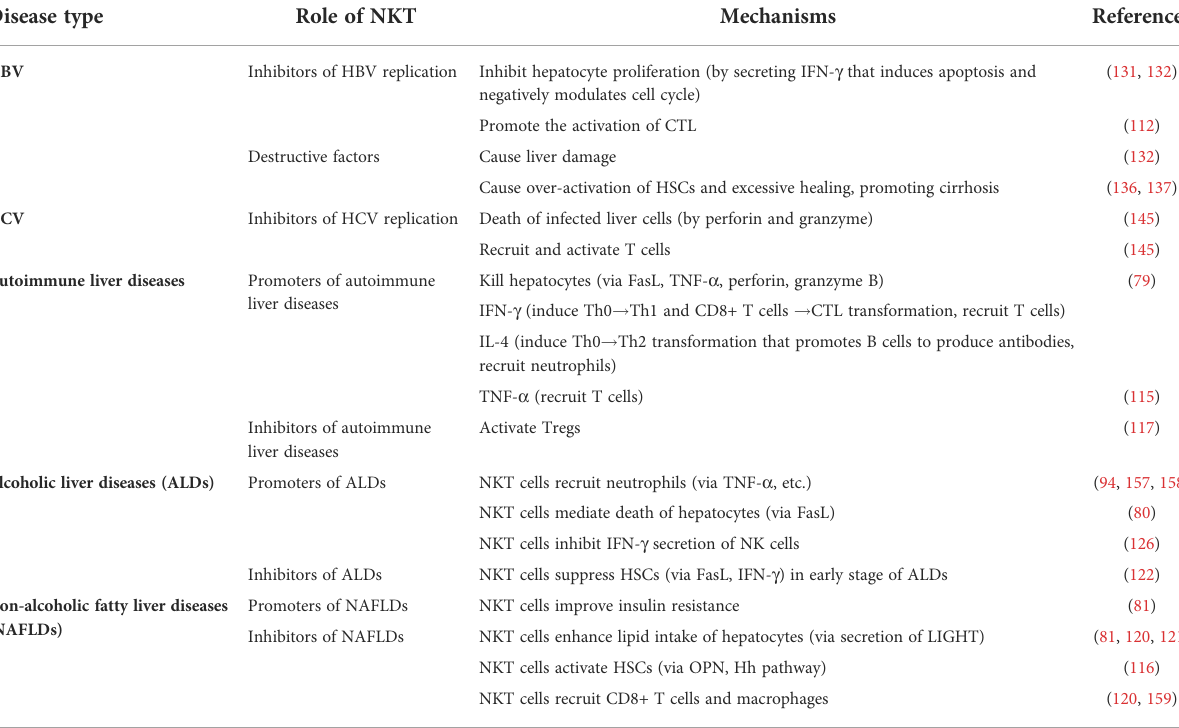
TABLE 4 Functions of NKT cells in autoimmune liver diseases, alcoholic liver diseases (ALDs) and non-alcoholic fatty liver diseases (NAFLDs). Disease type Role of